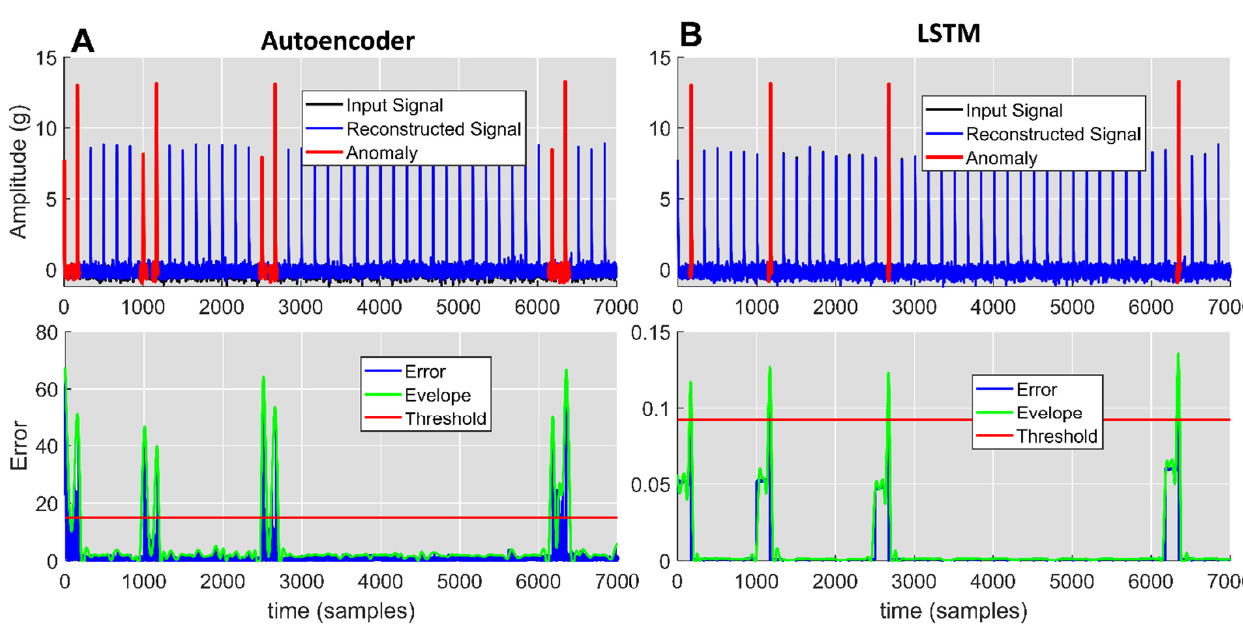
Figure 10. Detection of anomalies in the synthetic signal type: higher amplitude. ( A ) Autoencoder- based detector. ( B ) LSTM-based detector.